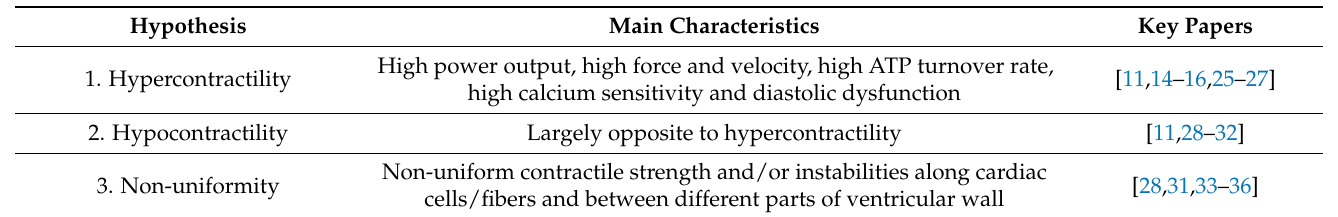
Table 1. Three main hypotheses for primary effects of HCM mutations (before pathologic remodeling) in focus in the present